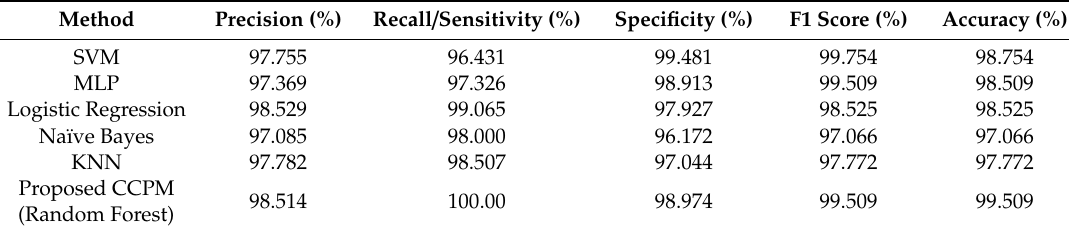
Table 17. Performance evaluation results based on iForest and SMOTETomek for Hinselmann.